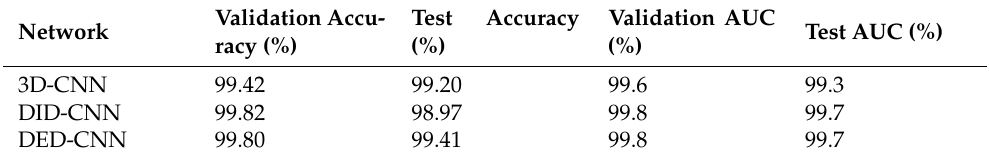
Table 7. The accuracy and AUC of the three proposed